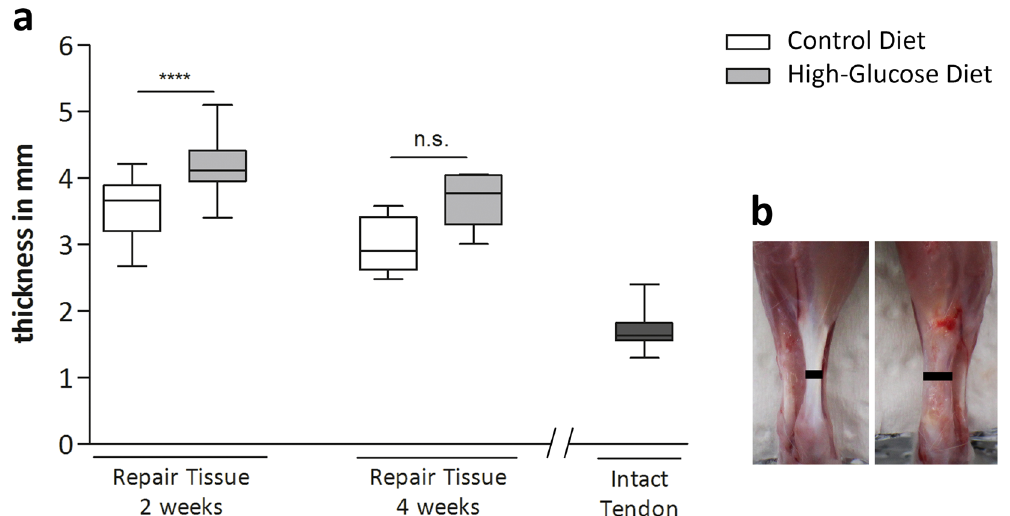
Figure 2. Repair tissue thickness measurements. Comparisons among the experimental groups 2 weeks after surgery revealed significantly increased thickness in the high-glucose group (n = 25), compared to the control diet group (n = 24, p < 0.0001; Mann-Whitney test, two-tailed) ( a ). 4 weeks after surgery no significant difference could be detected (n = 6; p = 0.0519; Mann-Whitney test, two-tailed). Tendon thickness was determined 3 mm proximal from the calcaneus ( b , black bars). Values for intact tendons are provided as a reference (n =